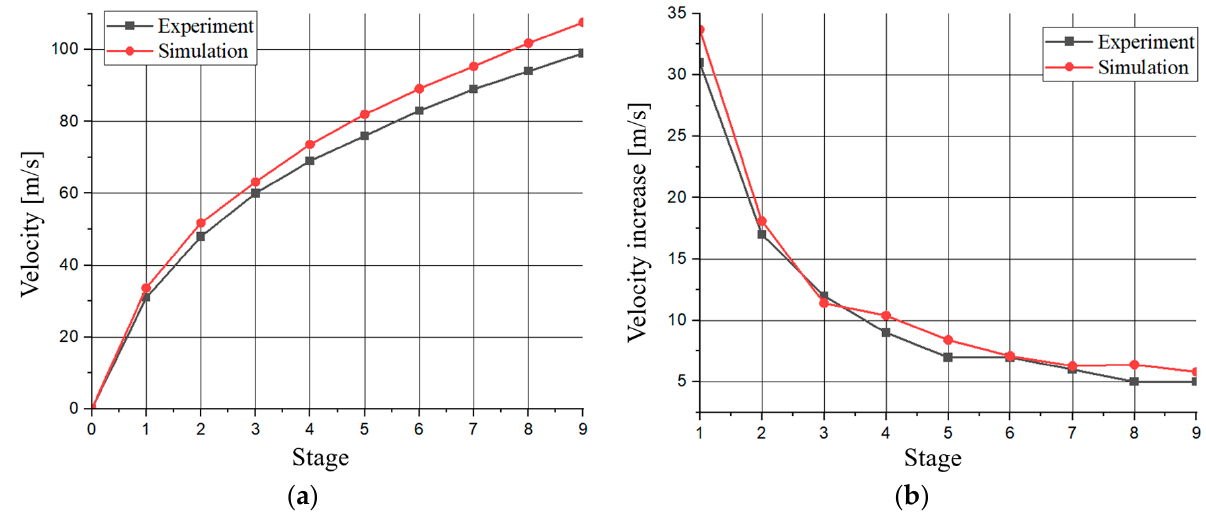
Figure 9. ( a ) Projectile velocity by stage ( b ) Projectile velocity increment by